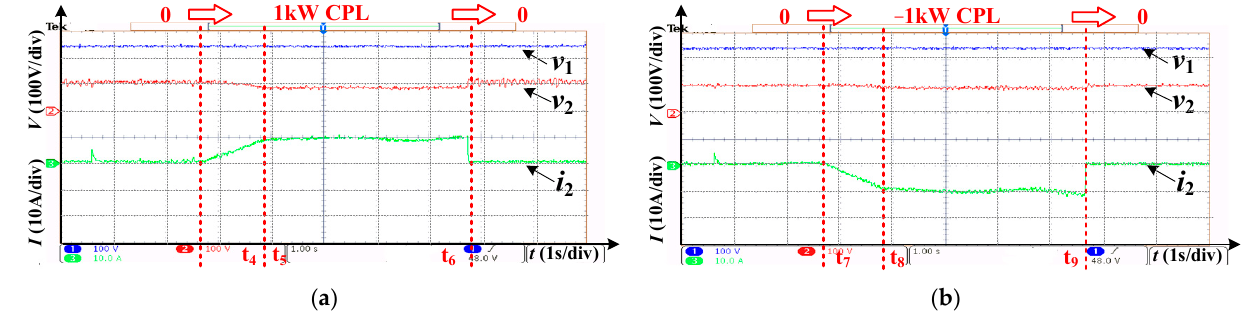
Figure 9. Waveforms in CPL perturbation experiment. ( a ) positive CPL load. ( b ) negative CPL load.